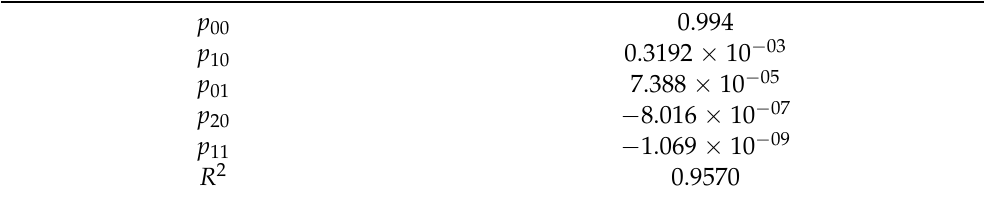
Table 4. Coefficients for diameter fit of Equation (27). Data for modeling the Pt diameter degradation were obtained from the references in Figure